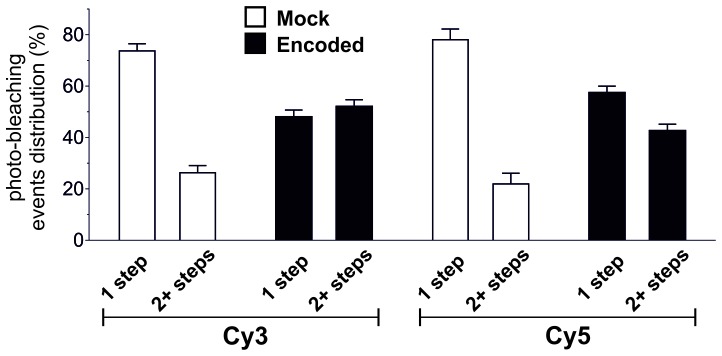
Photo-bleaching profiles for Cy3 and Cy5 spots in Encoded and Mock.For clarity, results from Figure 5C are shown here as relative photo-bleaching event distributions. In each case, the Encoded conditions produce a statistically significant difference (p<0.0001) over Mock distributions. All values are mean ± s.e.m. In total, following numbers were included: N = 1564 for encoded Cy3, N = 762 for encoded Cy5, N = 296 for mock Cy3, N = 300 for mock Cy5.